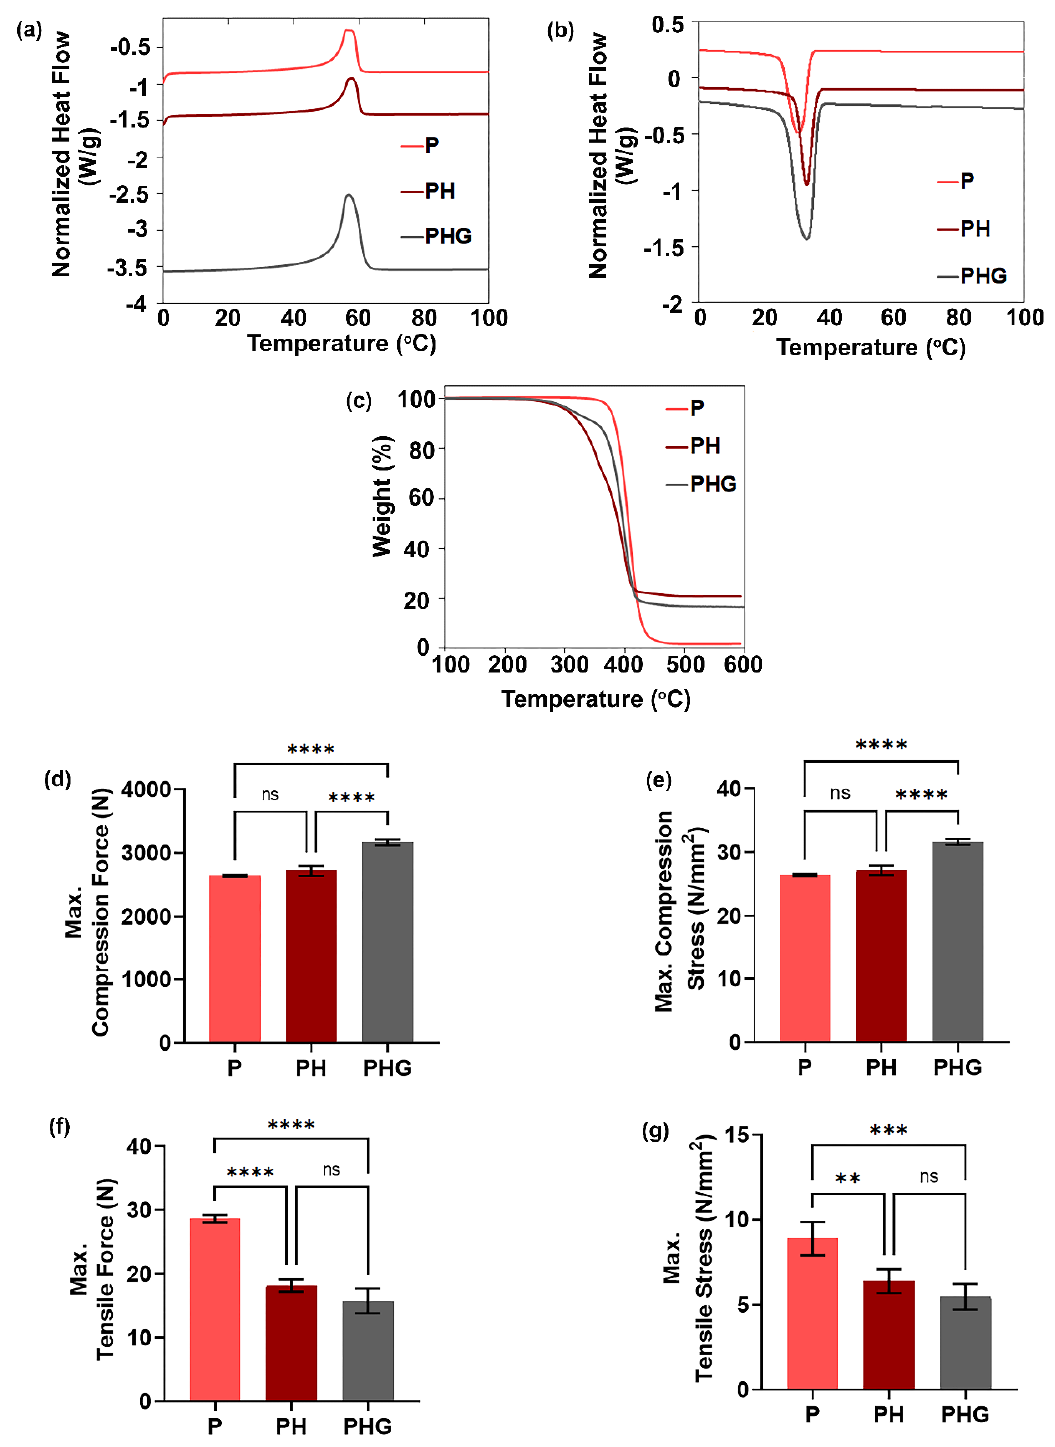
Figure 4. Thermal evaluation and mechanical characterization of the constructs. DSC